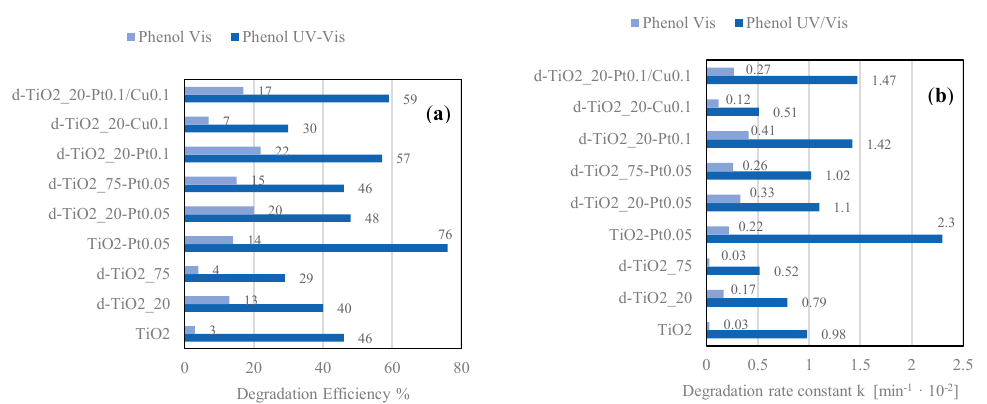
Figure 7. E ffi ciency of phenol degradation in UV-Vis and Vis light for d-TiO 2 -Pt / Cu photocatalysts, Figure 7. Efficiency of phenol degradation in UV-Vis and Vis light for d-TiO 2 -Pt/Cu photocatalysts, presented as % of degradation ( a ) and rate constant k ( b presented as % of degradation ( a ) and rate constant k ( b ).